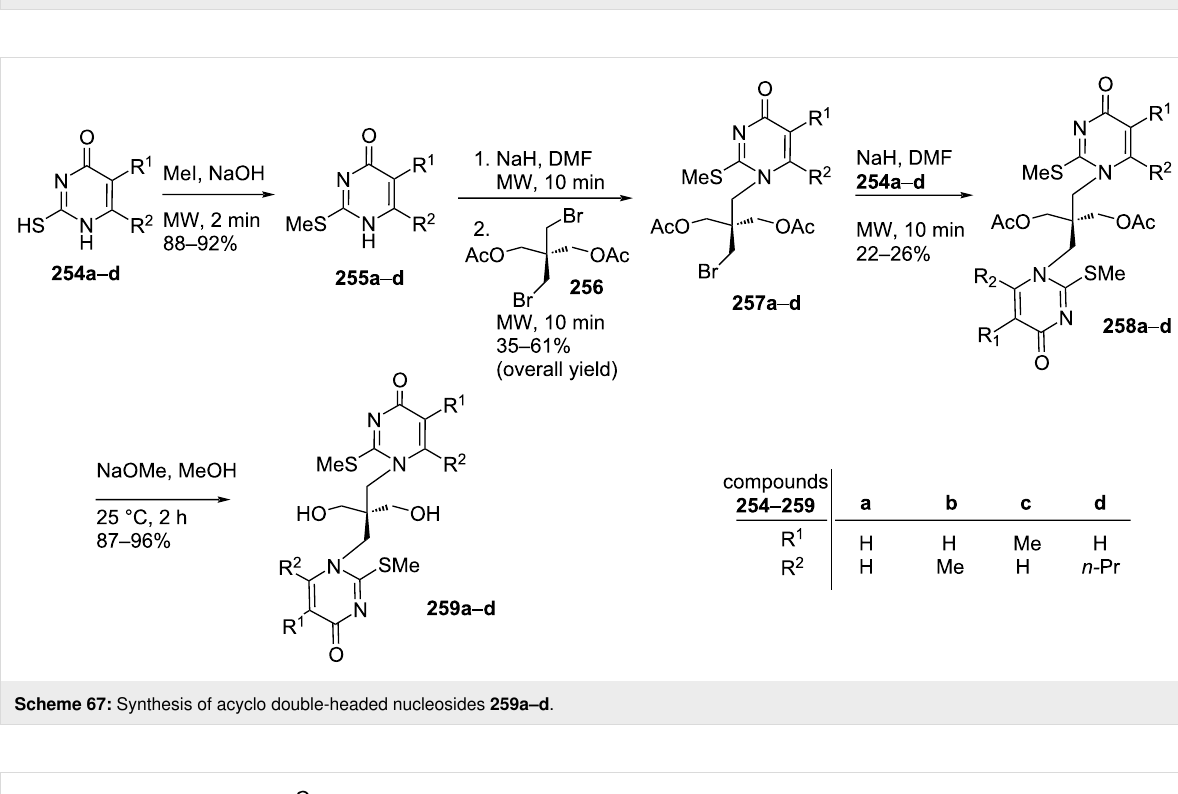
Scheme 66: Synthesis of acyclo double-headed nucleoside 253 .